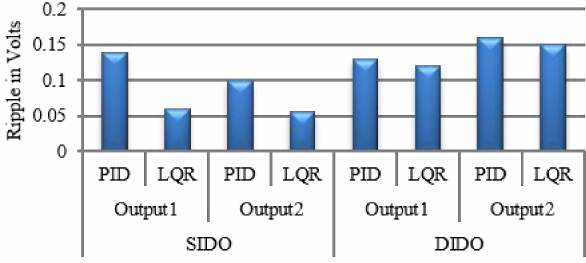
Figure 15. Performance comparison of SIDO and DIDO Converter with LQR and PID